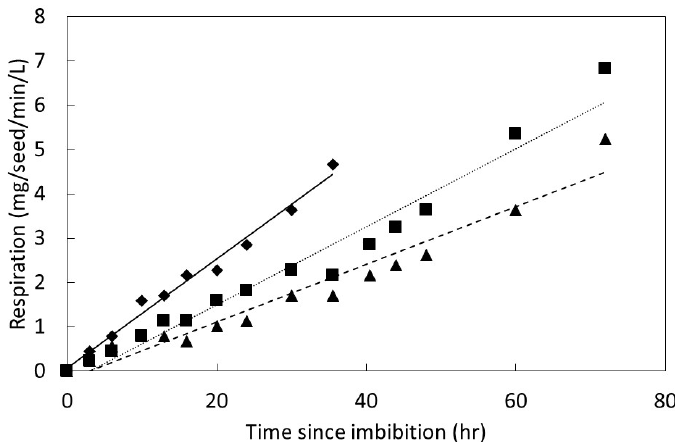
Figure 6. The influence of time since imbibition on seed respiration for Serianthes species, n = 6. Serianthes grandiflora (squares, dotted line), y = −0.261 + 0.088 x , r 2 = 0.96 ; Serianthes kanehirae (triangles, dashed line), y = −0.188 + 0.065 x , r 2 = 0.92 ; Serianthes nelsonii (diamonds, solid line), y = 0.082 + 0.123 x , r 2 = 0.98.